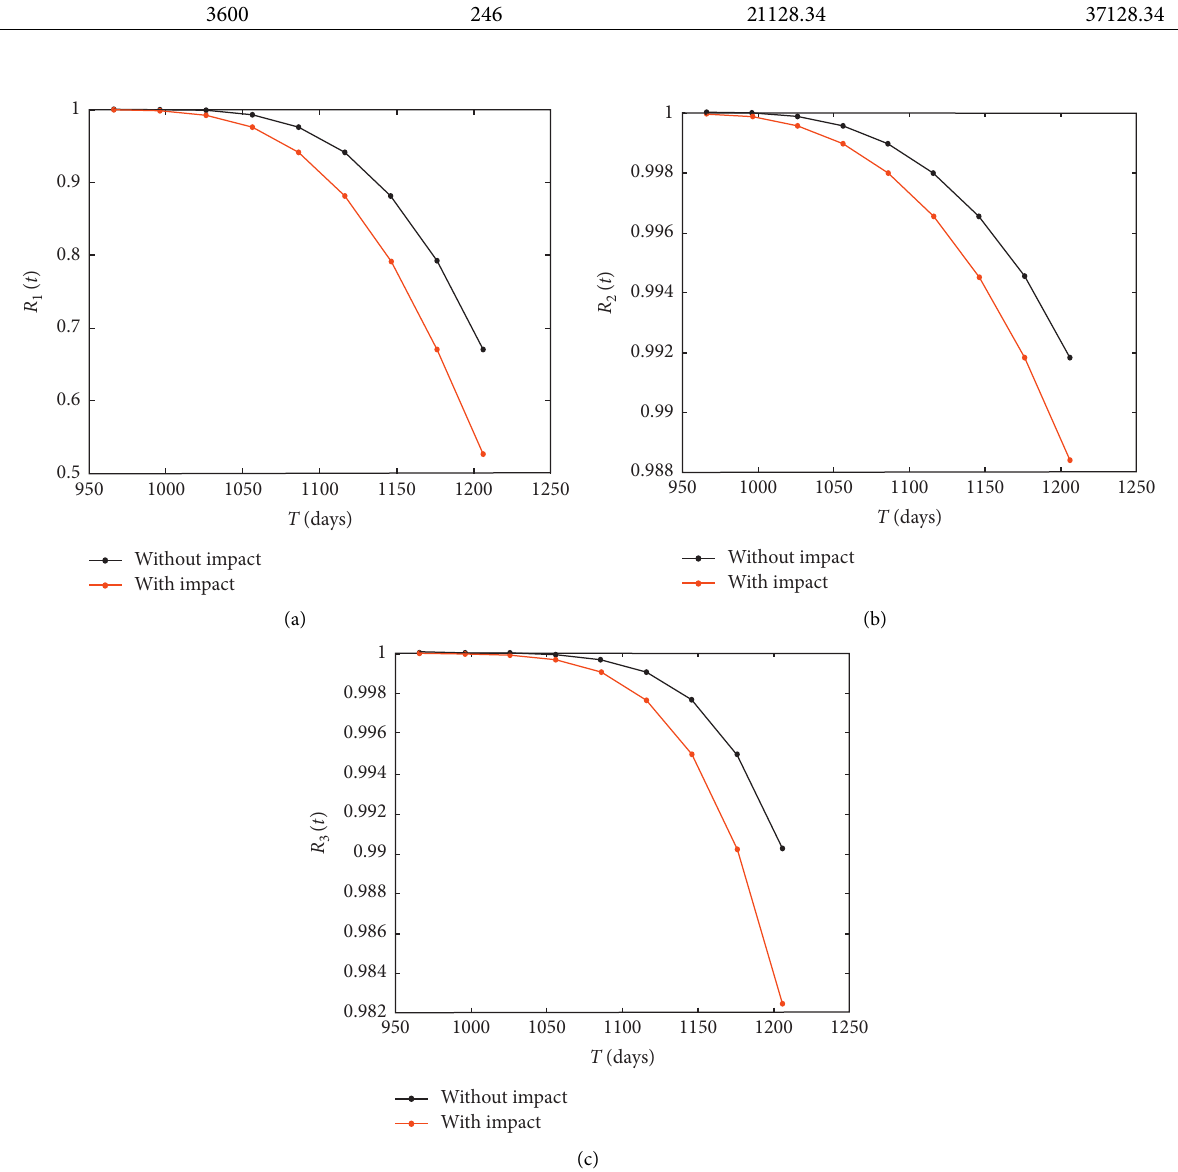
Figure 11: Component reliability with the disassembly operation impact. (a) The reliability of center gear. (b) The reliability of planetary gear. (c) The reliability of planetary